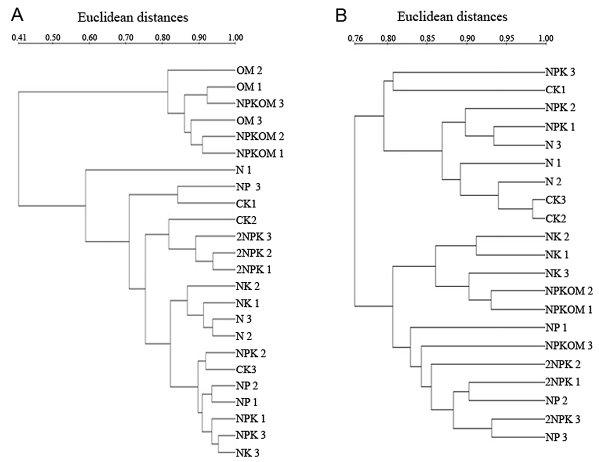
Fig. 6. Clustering analysis of PCR-DGGE banding patterns of ar- chaeal amoA genes as influenced by long-term field fertilization treatments in upland soil (a) and paddy soil (b) . The dendrogram was generated by Pearson’s product-moment coefficient and an un- weighted pair group method with an arithmetic mean clustering al- gorithm. The scale indicates the Euclidean